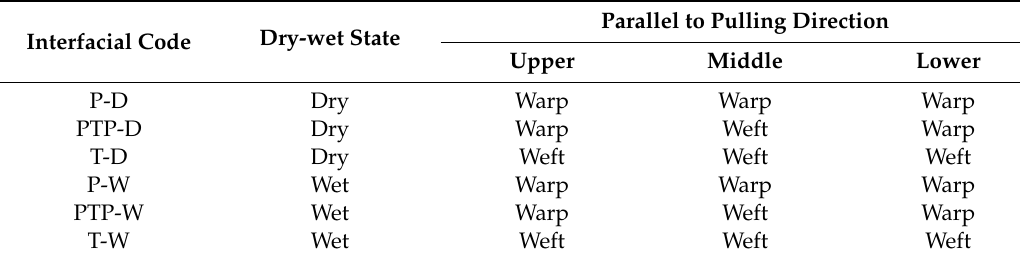
Table 2. The 6 kinds of interfaces used in the pull-out